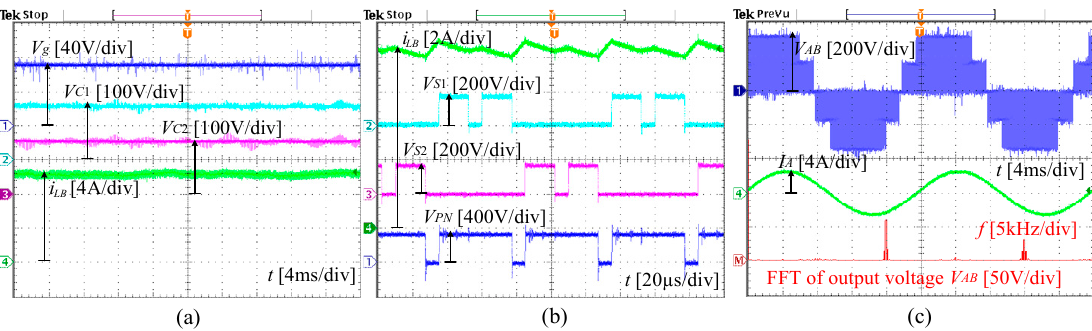
Figure 13. Experimental results of the inverter under the proposed method when V g = 70 V. From the top to bottom: ( a ) V g , V C 1 , V C 2 , and i LB ; ( b ) i LB , V S 1 , V S 2 , and V PN ; ( c ) V AB , I A , and FFT spectrum of the output voltage V AB .